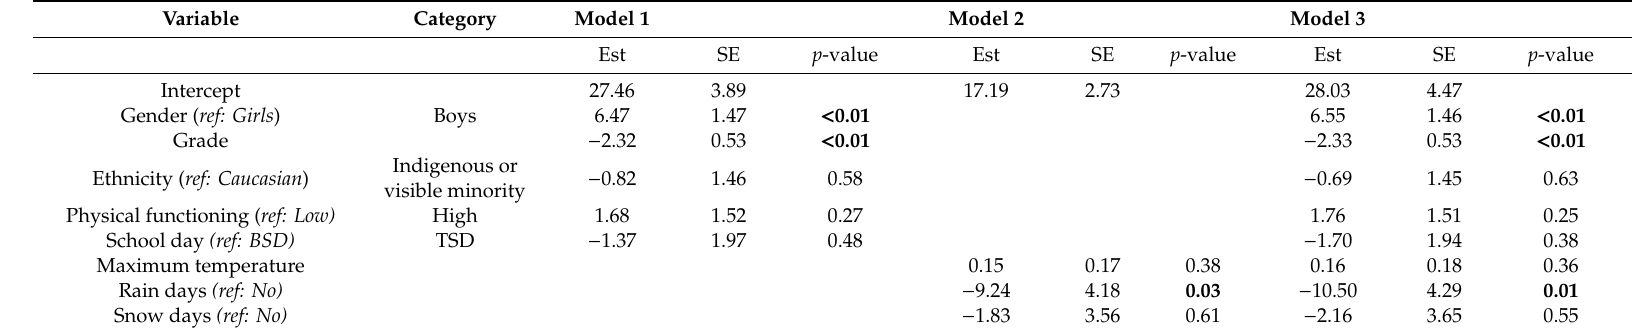
Table 3. The mixed model assessing the relationship between children’s curriculum time MVPA and child variables (Model 1), day variables (Model 2), and child- and day-level variables (Model